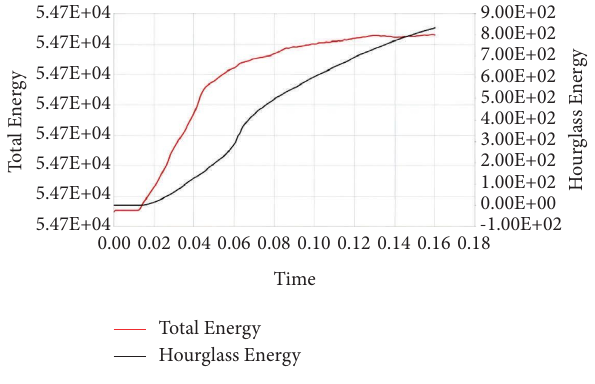
Figure 19: Hourglass energy to total energy.